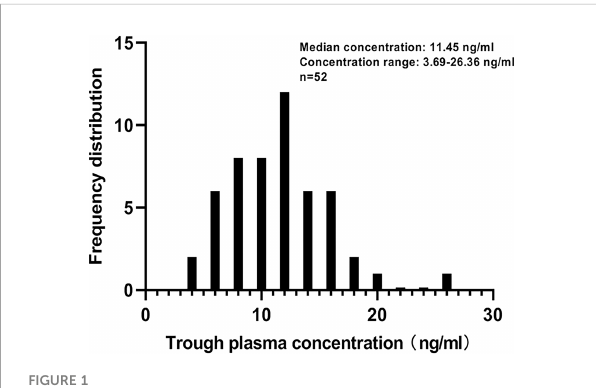
FIGURE 1 Distribution of anlotinib trough plasma